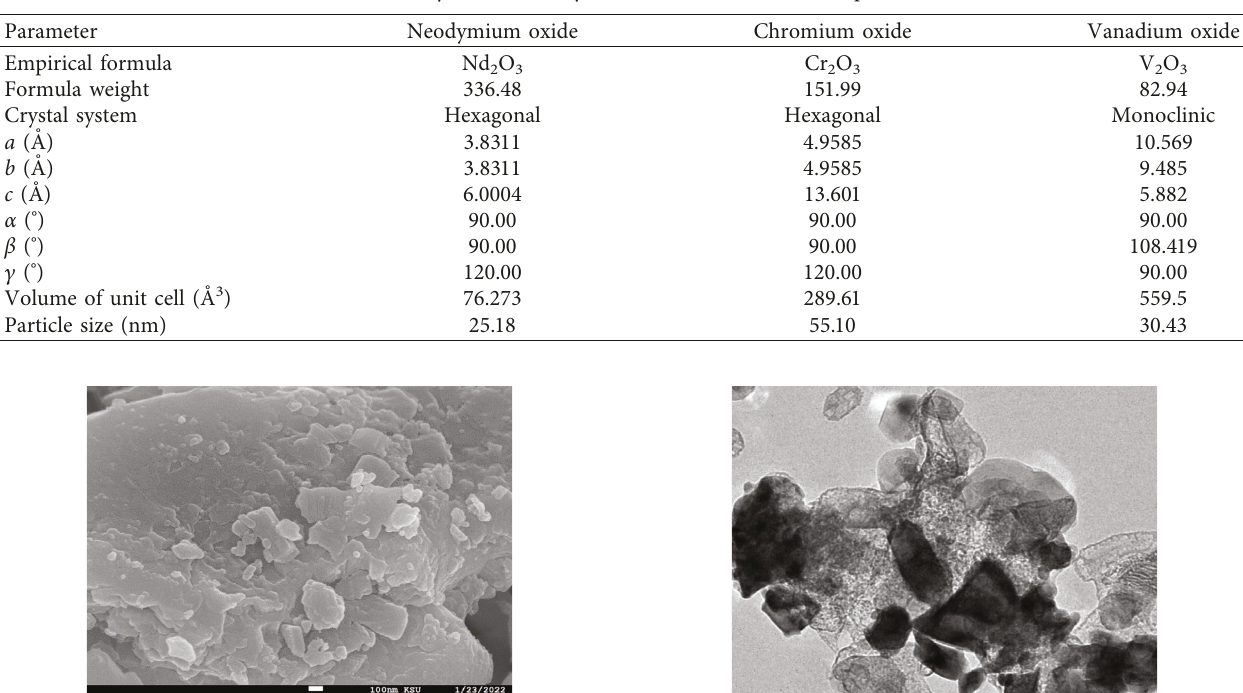
Table 7: X-ray diffraction crystal data of metal oxide